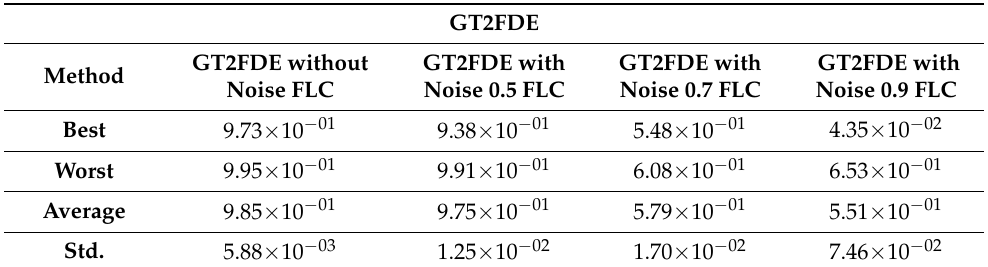
Table 6. Comparison of results using the GT2FDE optimization of the fuzzy controller.